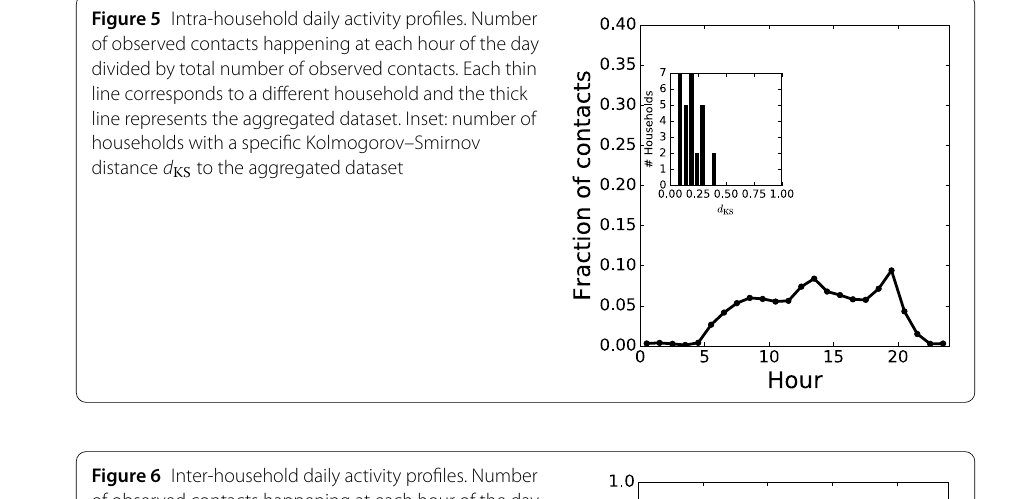
Figure 6 Inter-household daily activity profiles. Number of observed contacts happening at each hour of the day divided by total number of observed contacts. Each thin line corresponds to a different household and the thick line represents the aggregated dataset. Inset: number of households with a specific Kolmogorov–Smirnov distance d KS to the aggregated